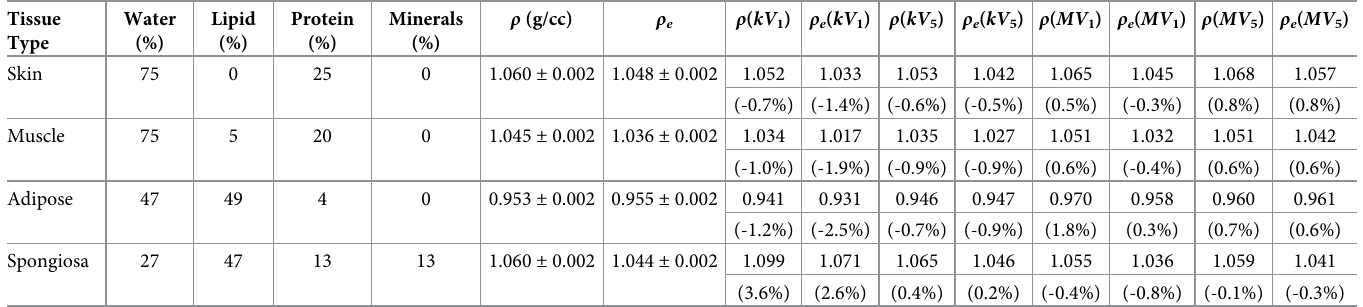
Table 2. Tabulated compositions and calculated ρ e by imaging for synthetic tissue phantoms.